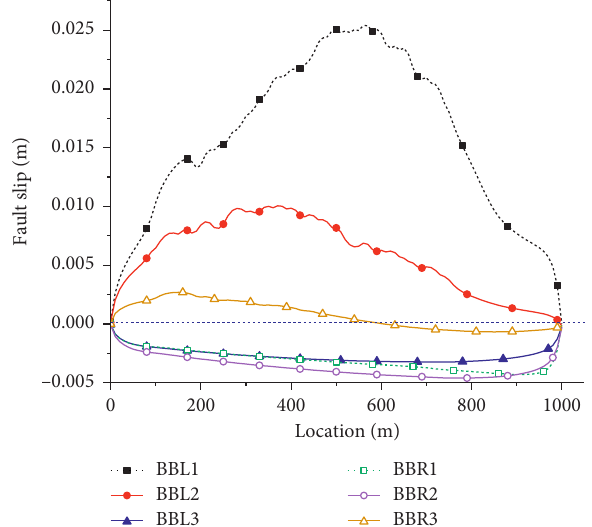
Figure 19: Fault slip along the fault plane when region BB changed in the horizontal direction.